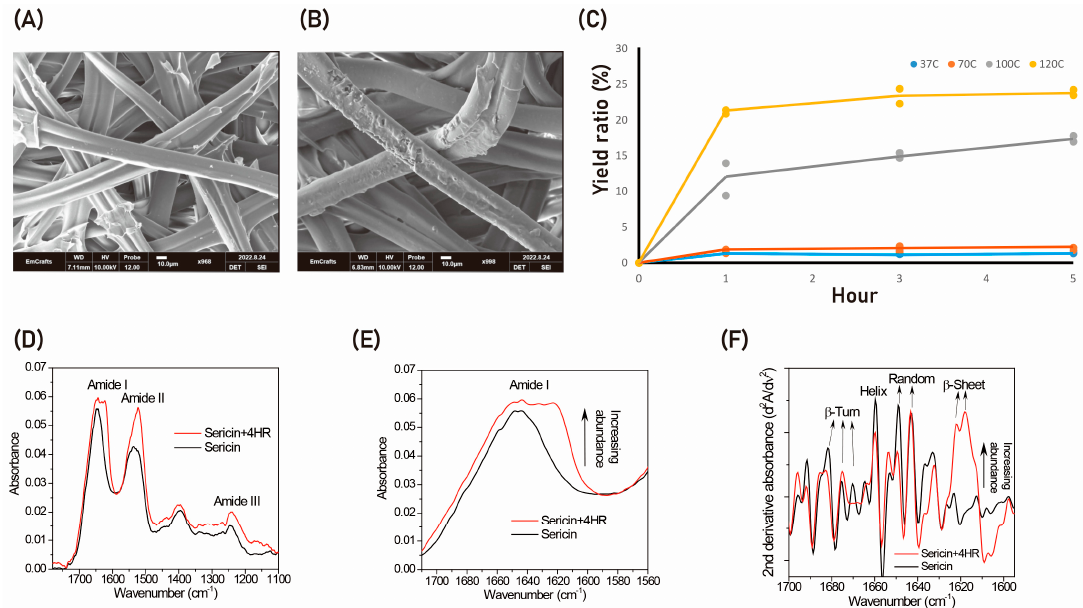
Figure 1. The effect of 4HR pretreatment before degumming. ( A ) Micro-computerized tomography (mCT) of an untreated cocoon, showing silk fibroin covered by silk sericin. ( B ) mCT of a cocoon treated with 0.5% 4HR in ethanol, showing partial damage to the silk sericin coating, although most of the pretreated cocoon looked similar to the untreated cocoon. ( C ) Dependence of the yield ratio of collected sericin after degumming on the temperature of the degumming solution and the duration of degumming. ( D – F ) FT-IR analysis, showing ( D ) that the amide I band, which corresponds to C=O stretching, was highly dependent on the conformation of protein secondary structures; ( E ) that 4HR pretreatment of silk sericin resulted in increased absorption at ~1620 cm − 1 ; and ( F ) that the broad amide I band could be split into several fine peaks by calculating the second derivative of the infrared absorption spectrum. In addition, the abundance of β -sheet secondary structure at ~1620 cm − 1 was higher, whereas the abundances of random, helix, and β -turn structures (at 1649, 1660, and 1682 cm − 1 , respectively) were markedly lower, in 4HR treated than in untreated sericin protein. Examination of their UV spectra showed that 4HR and sericin had different peak patterns, with 4HR having an additional peak at 278 nm (Supplementary Figure S1). Thus, when compared with sericin alone, 4HR-bound sericin had an additional peak at 278 nm. This feature allowed release of sericin-bound 4HR to be analyzed spectrophotometrically. Incubation of sericin-bound 4HR in PBS resulted in rapid release of 4HR for 40 h,